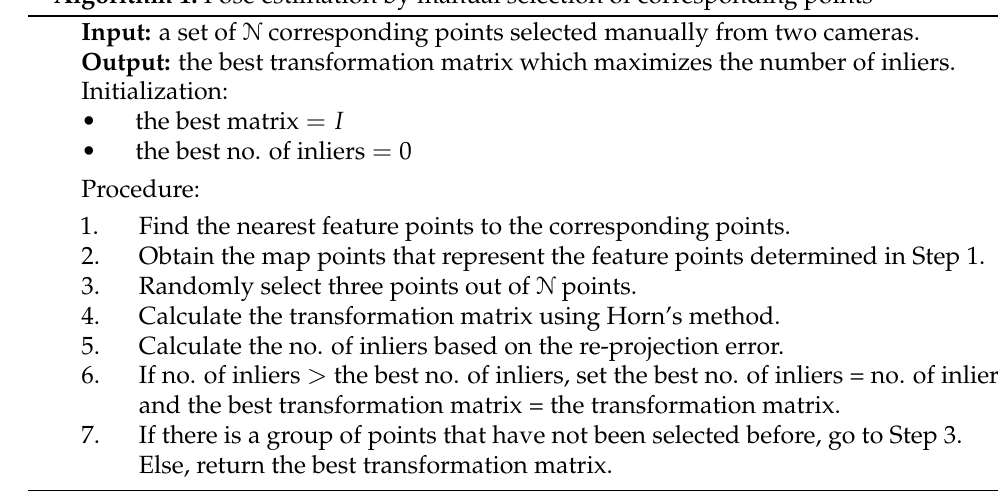
Algorithm 1: Pose estimation by manual selection of corresponding